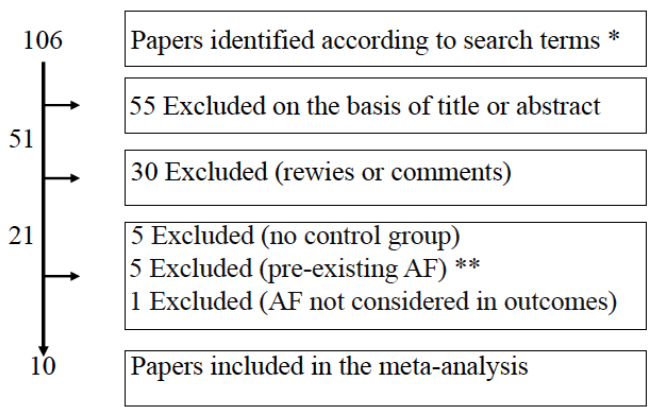
Figure 1. Flow-chart of the analysis performed according to Preferred Reporting Items for Systematic Reviews and Meta-Analyses guidelines (PRISMA). After screening of literature according to search terms, most paper were excluded for reasons indicated in the squares. * Search terms: “atrial fibrillation” AND (“bariatric surgery” OR “biliopancreatic diversion” OR “gastric bypass” OR “roux-en-Y” OR “sleeve gastrectomy” OR “biliointestinal bypass” OR “adjustable gastric banding”) ** AF atrial fibrillation.